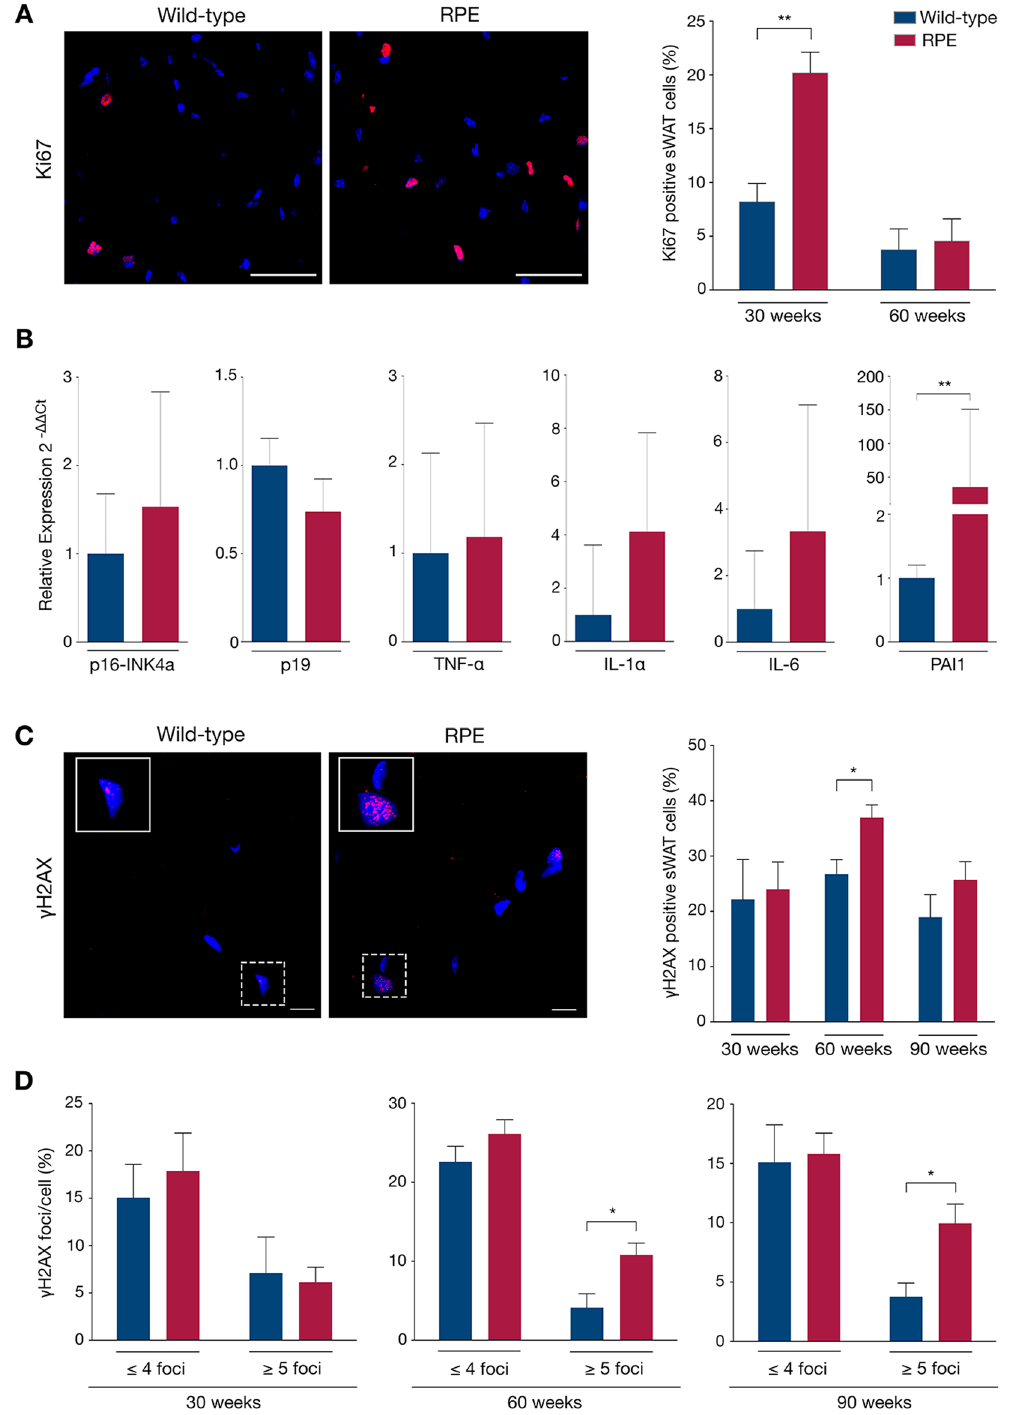
Figure 4. sWAT characterization: Hyperproliferation, senescence and DNA damage. ( A ) Proliferation was determined by immunofluorescent staining of Ki67 (red) in cell nuclei (blue), subsequently analyzed as the percentage of positively stained cells in mutant and control sWAT. ( B ) Senescence was determined via quantitative RT-PCR of specific target genes. ( C , D ) γ H2AX immunofluorescent staining showing DNA DSBs (red) in cell nuclei (blue) of wild-type and RPE sWAT, first analyzed for the frequency of positive cells ( C ) and then for the frequency of γ H2AX foci per cell ( D ). Scale bars: A = 50 μ m, C = 10 μ m. Data are represented as mean ±